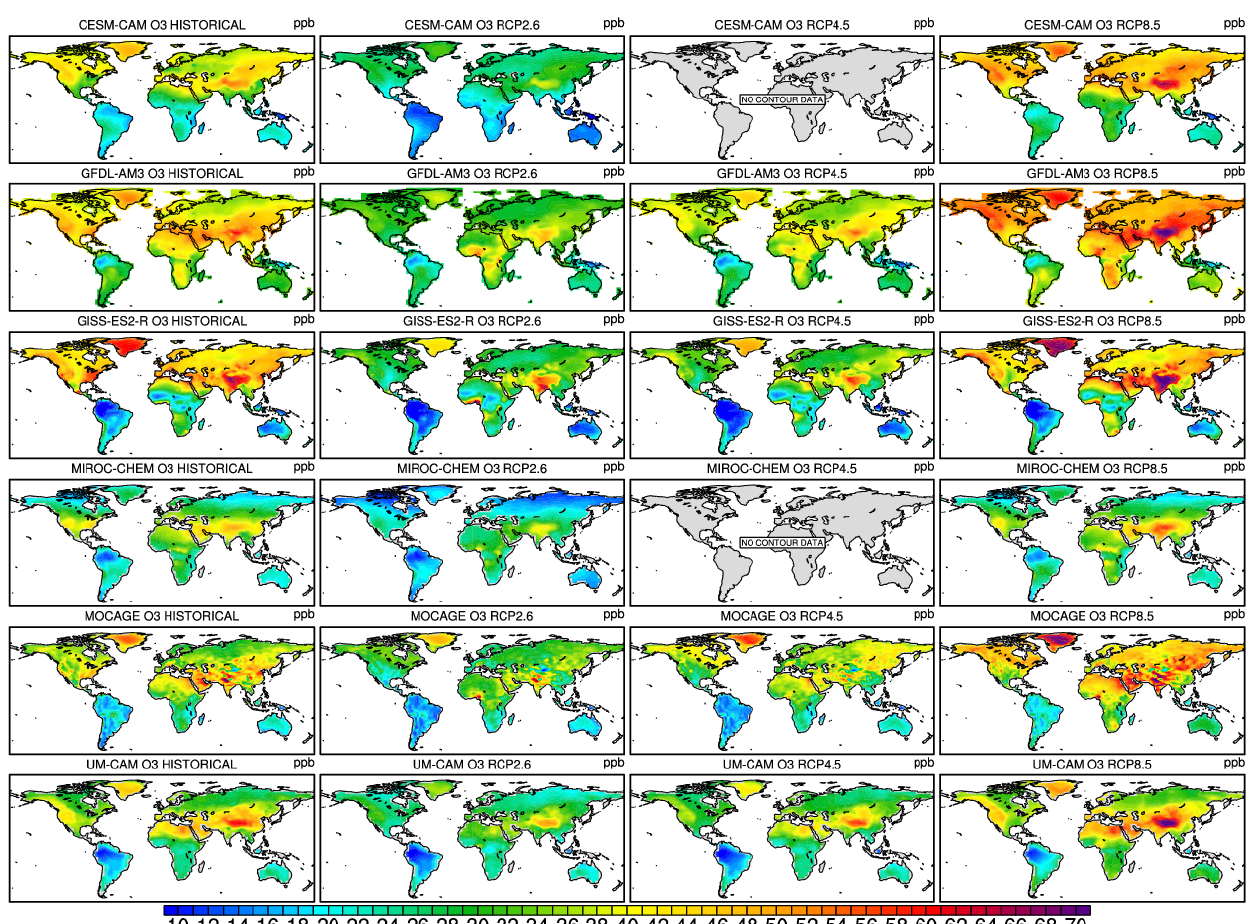
Figure 1. Surface ozone average concentrations (in ppb) at the lower model layer for each ACCMIP model over the historical period and for RCP2.6, RCP4.5 and RCP8.5 simulations by 2100. The data are missing for two models under RCP4.5 (“no contour